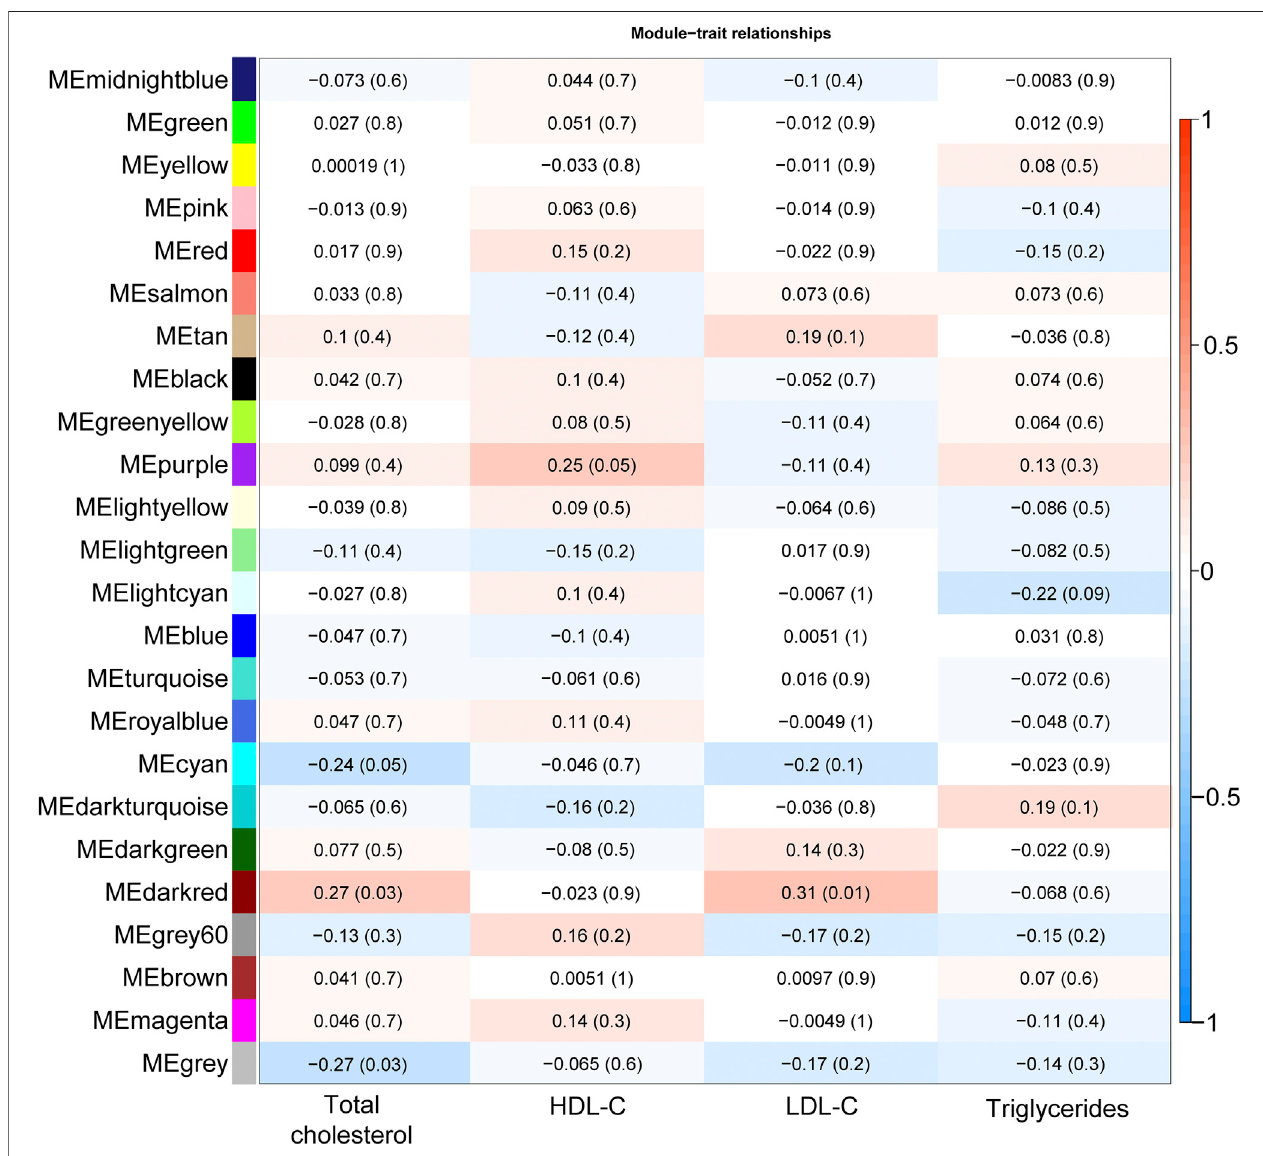
FIGURE1| Heatmap plotillustratingthecorrelation ofmodule-lipidtraitrelationshipsforthedetectionofthegenemodules mostlyassociatedwithlipidtraits.Each elementin theheatmap representsthe Pearson correlation (and P-value) between module eigengenes(y-axis; calculated using the fi rst principal component ofthe gene expression matrix of each module) and lipid trait (x-axis); the color gradient represents the strength of the correlation.